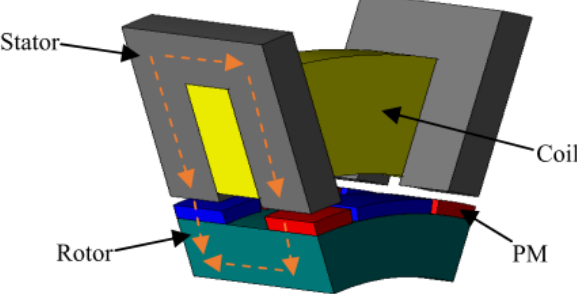
Figure 5. Single-sided transverse flux PM machine with one pole pair [66].